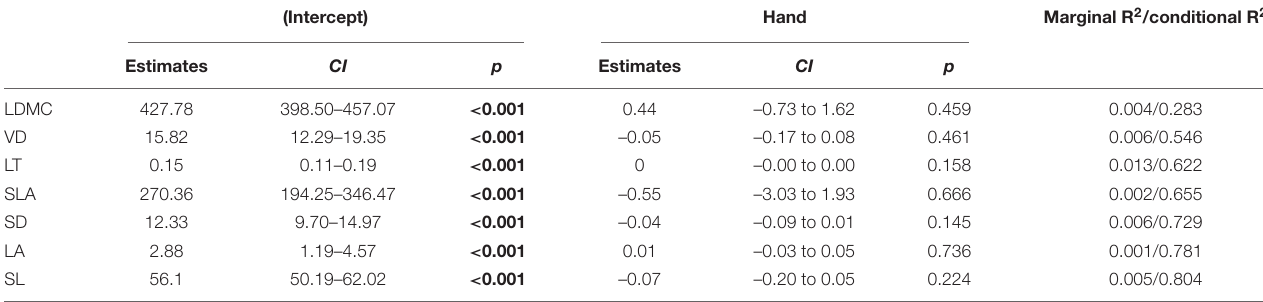
TABLE 2 | Results of linear mixed models including height above nearest drainage (HAND) as fixed factor and species and local conditions (plot) as random